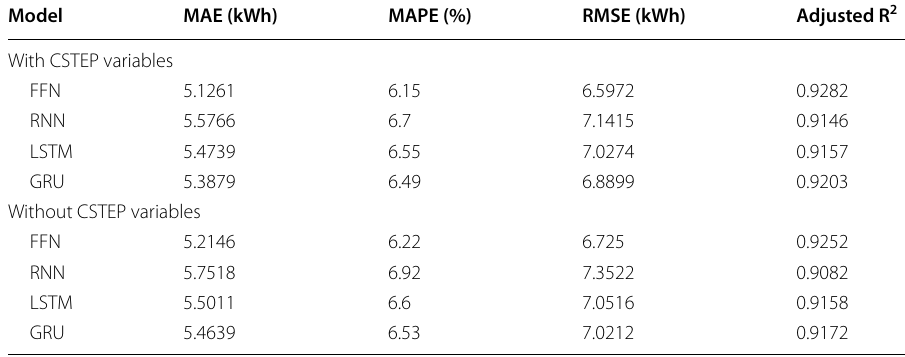
Table 7 24-h forecast metrics